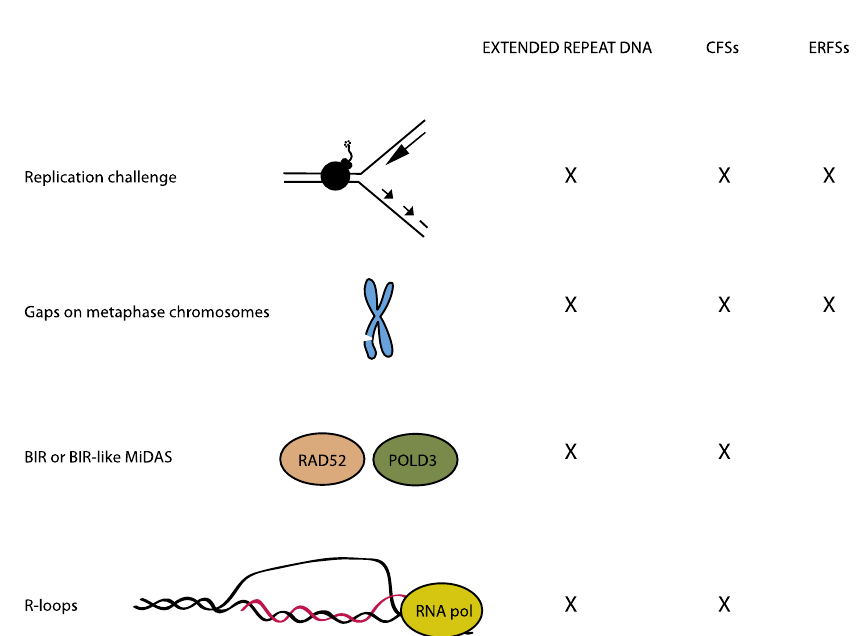
Figure 1. Similarities of three types of regions causing replication problems. Schematic summarizing similarities of expanded short tandem repeat sequence, common chromosomal fragile sites (CFSs), and early replicating fragile sites (ERFSs). See text for further details.